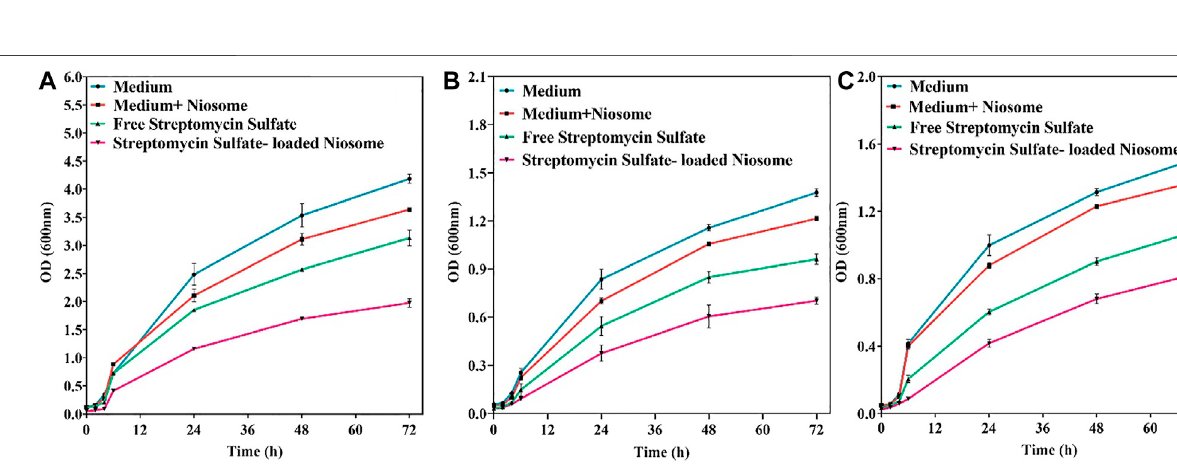
Frontiers in Bioengineering and Biotechnology |